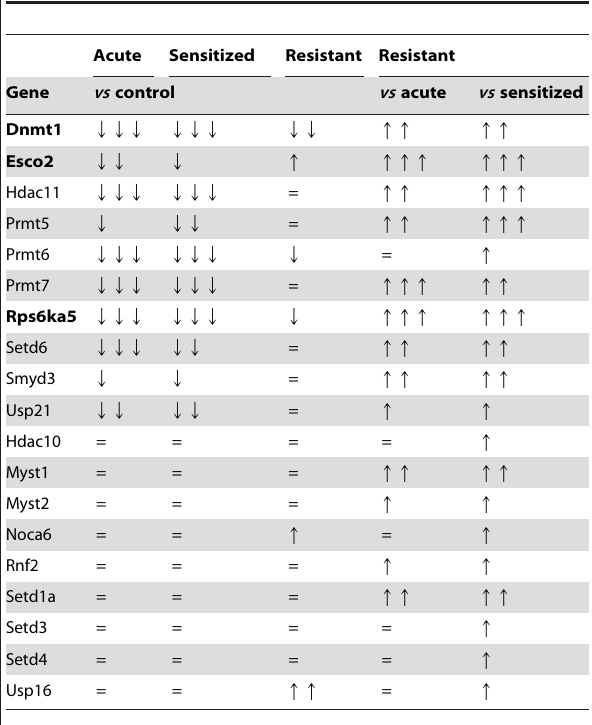
Table 1. Ethanol challenge in resistant and sensitized mice is associated with striatal epigenetic-related genes regulation.